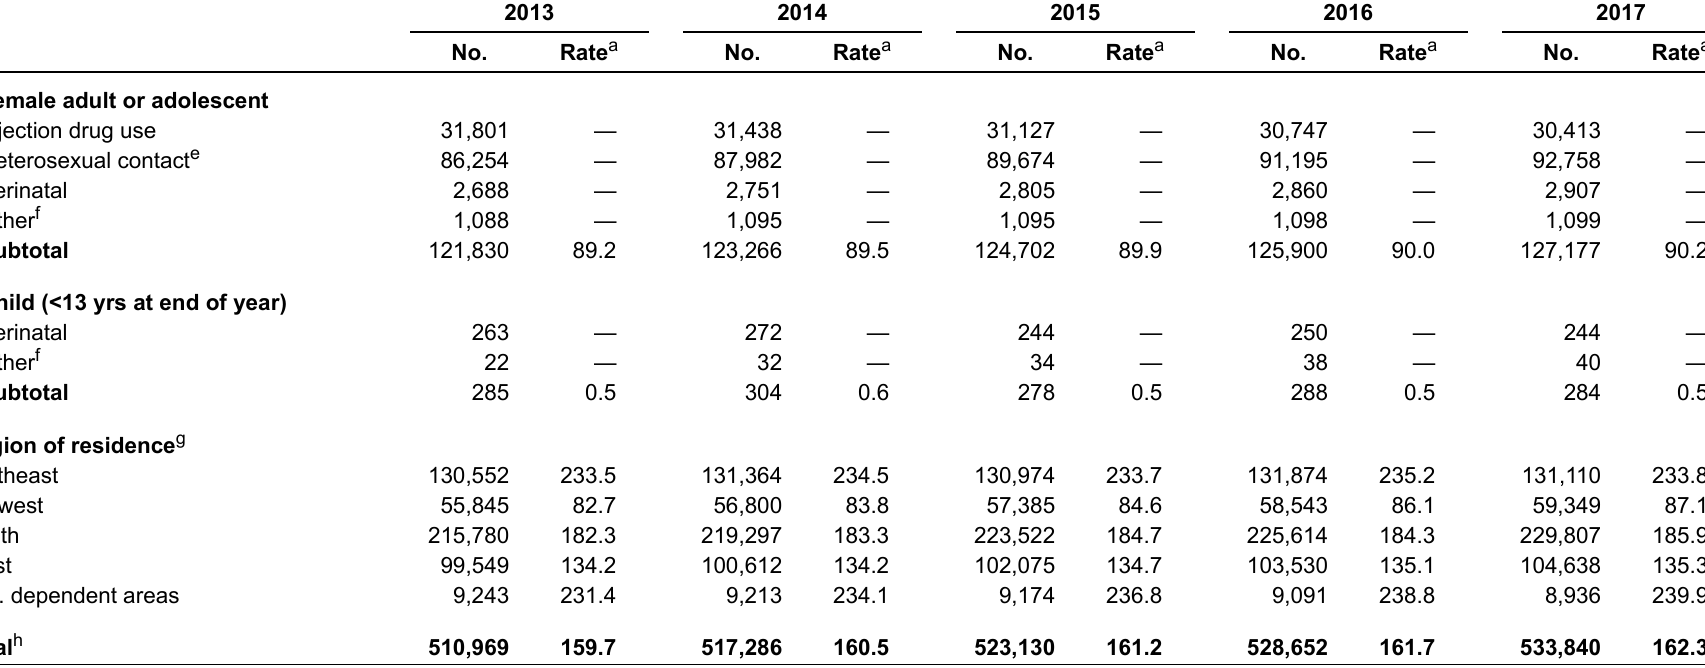
Table 23b. Persons living with diagnosed HIV infection ever classified as stage 3 (AIDS), by year and selected characteristics, 2013–2017—United States